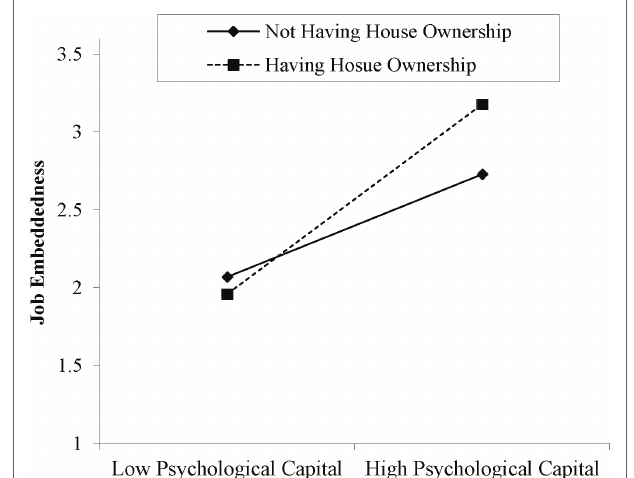
FIGURE 1 | Moderation role of house ownership between psychological capital and job